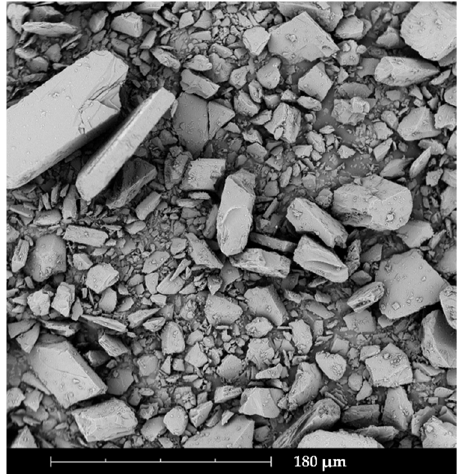
Figure 1. SEM image of losartan potassium with 730-fold magnification.